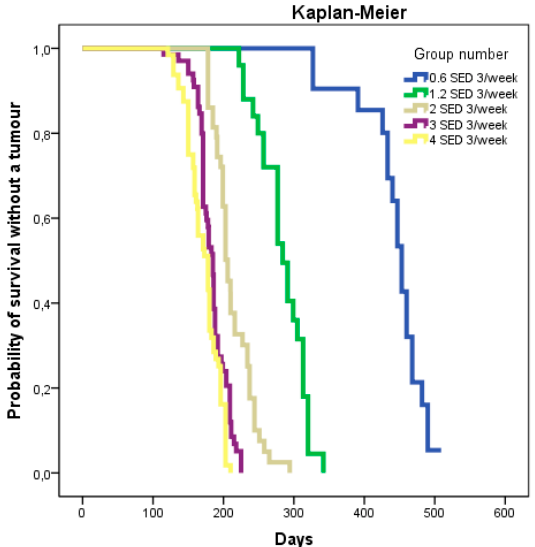
Figure A2. Dose–response study: A Kaplan–Meier plot showing tumor-free survival (Groups 6–10). The Kaplan–Meier plot demonstrates that there are significant differences in time until tumor development between the 5 groups irradiated with 0.6, 1.2, 2, 3 or 4 SED 3×/week, p < 0.005.